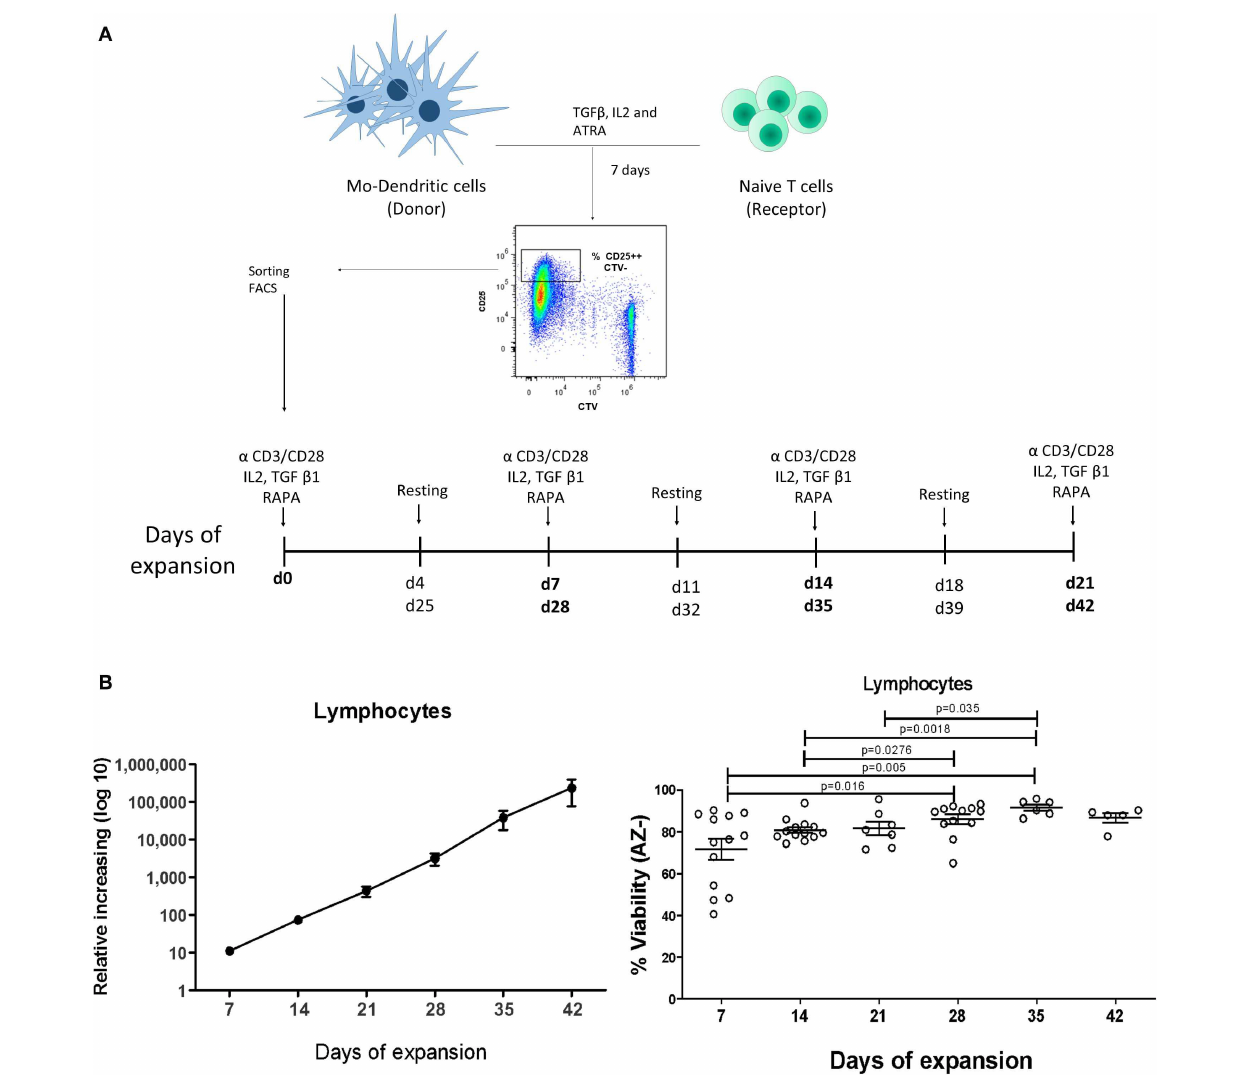
FIGURE 2 | Purification and expansion of allospecific iTregs. (A) Schematic representation of the protocol used for the generation and expansion of allospecific iTregs. Mo-DCs were co-cultured with CTV-labeled naïve T cells from an unrelated individual for 7 days and proliferating CD4 + CD25 ++ CTV − cells (allospecific iTregs) were sorted by FACS and polyclonally expanded for 6 weeks. The phenotype, suppressor function, and cytokine production were evaluated. (B) Cell counts (left graph) and viability (right graph) of Tregs expanded for 6 weeks. Data represent the mean ± SEM from n = 5–15 donors from five independent experiments. The statistical analysis was performed using the non-parametric Mann–Whitney test, two-tailed. P < 0.05 was considered statistically